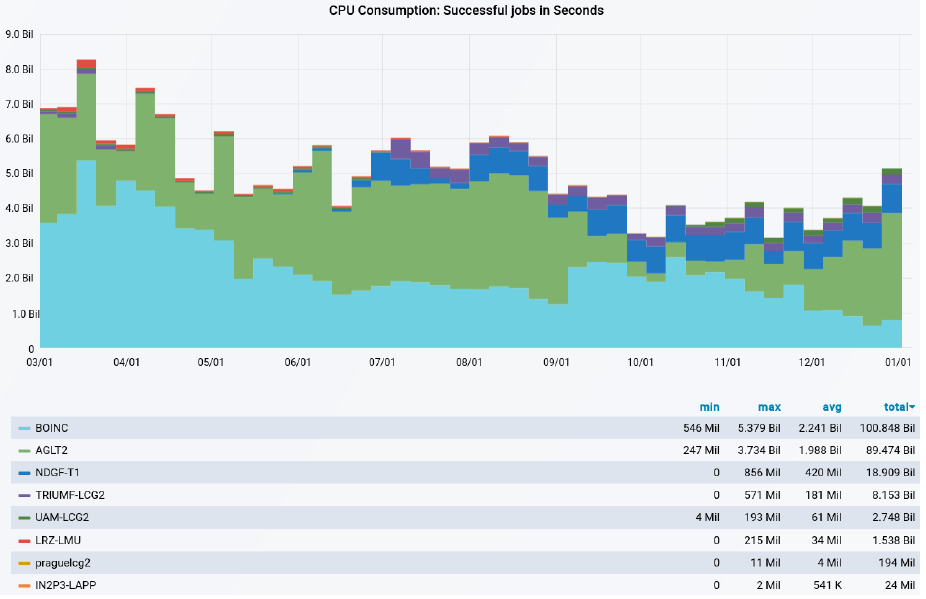
Figure 1. CPU consumption per contributing site from March to December 2019, in CPU seconds per